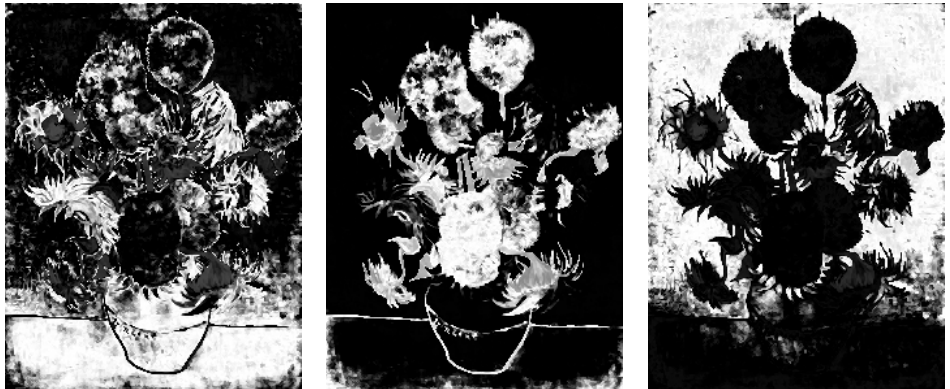
Figure 9. Sunflowers R Band—compression rate 0.25—segmented images.